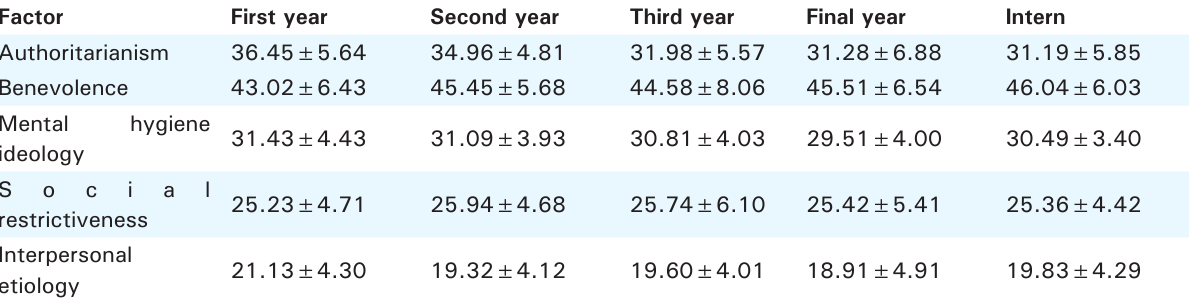
Table 3. OMI score (Mean ± Standard Deviation) in medical students and interns by year of study.